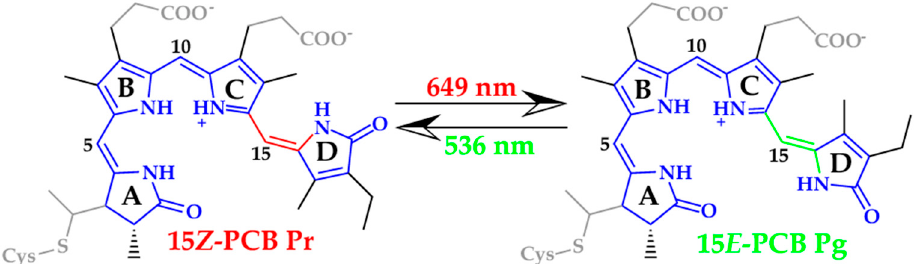
Scheme 1. Schematic representation of the PCB structures in the red- and green-absorbing forms. The differences between the two forms are highlighted in red and green for P r and P g , respectively. The wavelengths refer to the lowest energy absorption maxima of the measured spectra [13,14]. The QM region consisting of 42 atoms (QM42) is shown in blue, whereas the atoms of the QM region with 66 atoms (QM66) are shown accentuated in black.